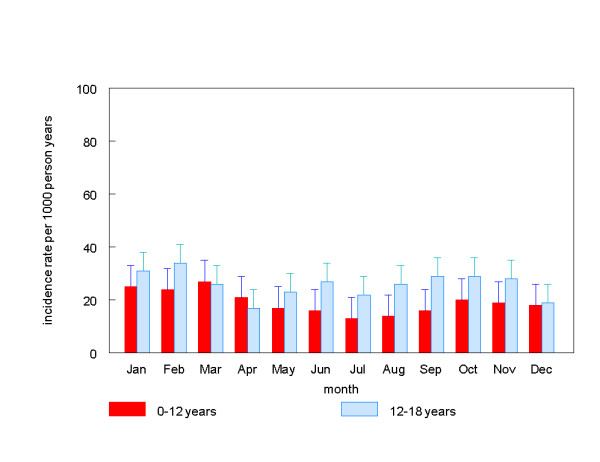
Incidence rates throughout the year by age group, 95% error bars.